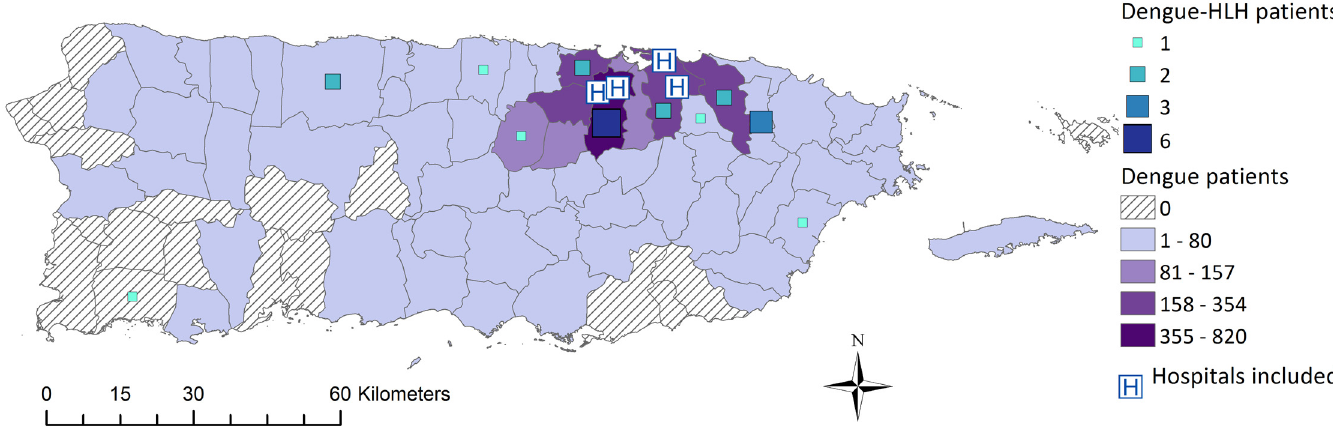
Fig 2. Municipality of residence of dengue and dengue-associated hemophagocytic lymphohistiocytosis patients identified at four referral hospitals in, Puerto Rico, January 2008 – June 2013.